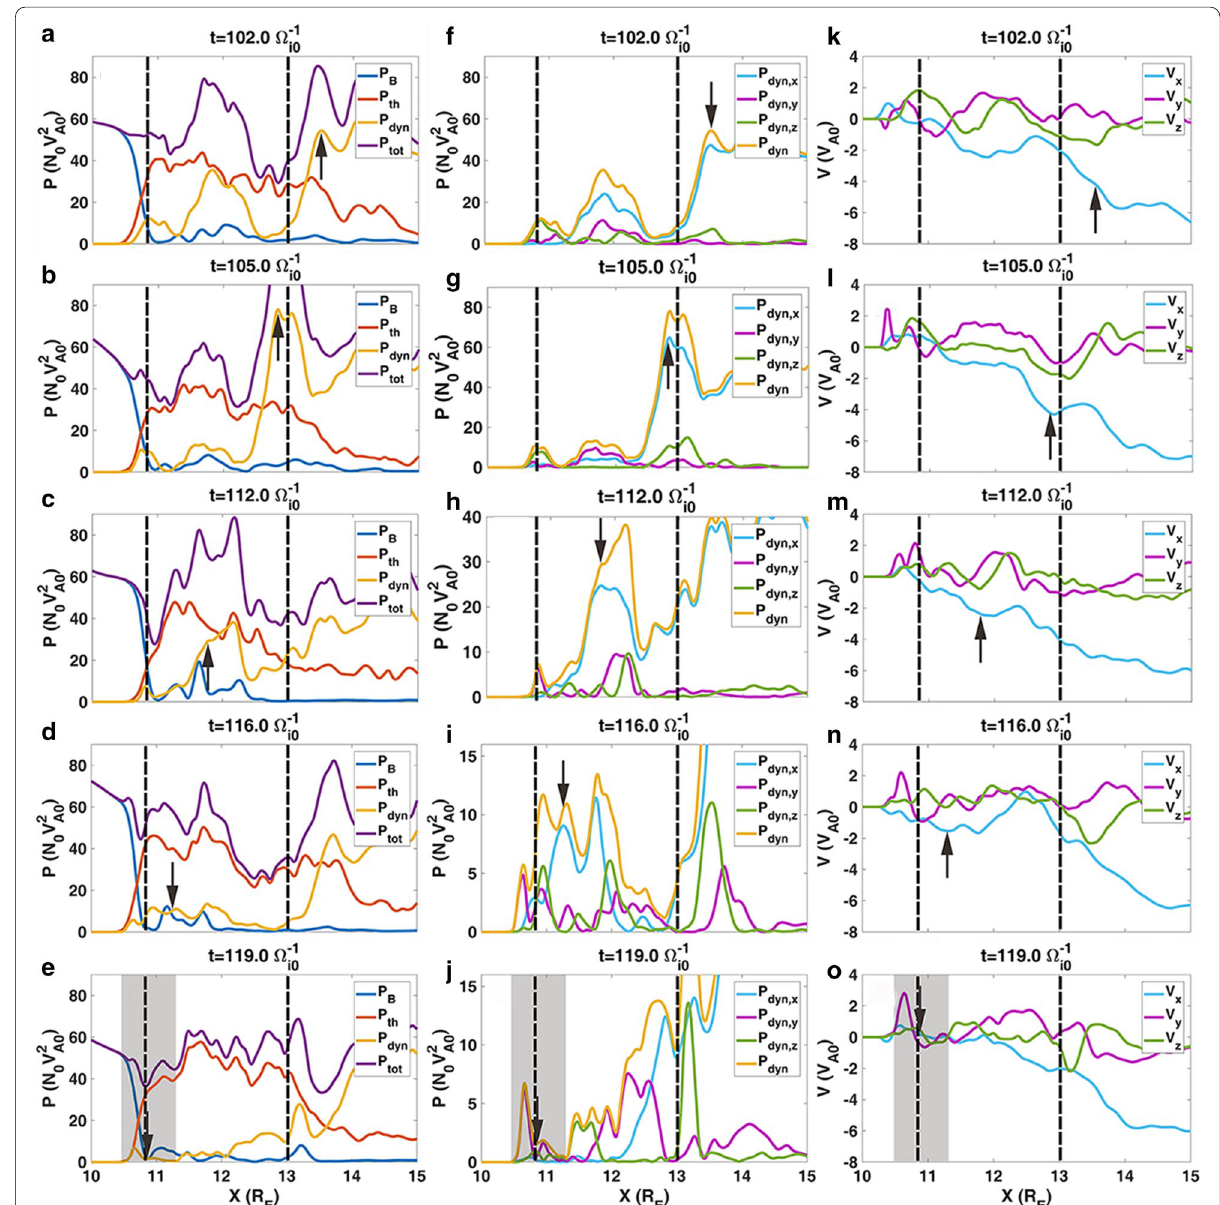
Fig. 2 Case I: pressure and flow velocity components along the Sun–Earth line at 5 different moments of time. a – e Evolution of magnetic pressure ( P B ), thermal pressure ( P th ), dynamic pressure ( P dyn ) and total pressure ( P tot ( P dyn, x , P dyn, y , P dyn, z ), as well as dynamic pressure ( P dyn flow velocity components ( V x , V y , V z ). The black arrows trace a series of dynamic pressure pulses originating from the ion foreshock, propagating through the magnetosheath, and finally interacting with the magnetopause. The shaded areas in e , j and o mark the location inside and near the magnetopause, where the deflection of magnetosheath flow occurs. The vertical black dashed lines reference the average positions of the magnetopause and the bow shock,